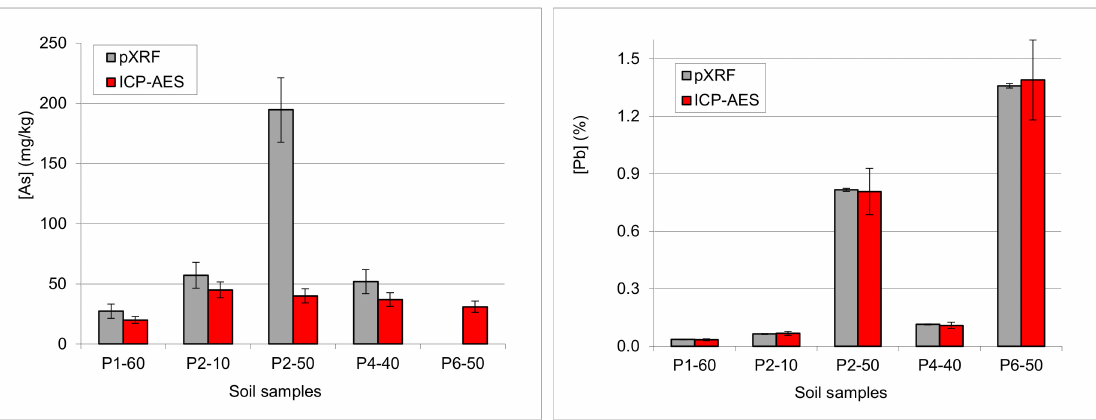
Figure 14. Pb-As interference, with Pb > As. As concentrations are not determined or